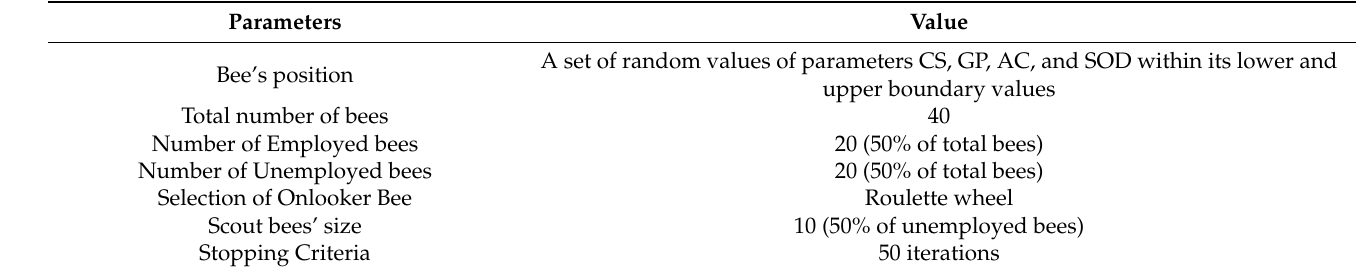
Table 7. ABC algorithm